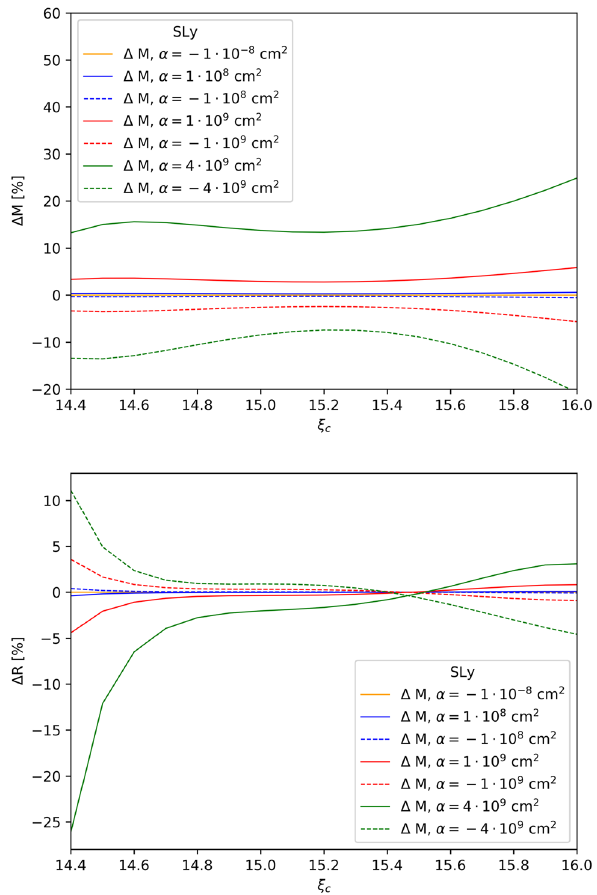
Fig. 4 Differencebetweenthemass(upperpanel)andtheradius(lower panel) obtained, given a central density value ξ , with f ( R , Q ) = R + α R 2 and GR, for the SLY